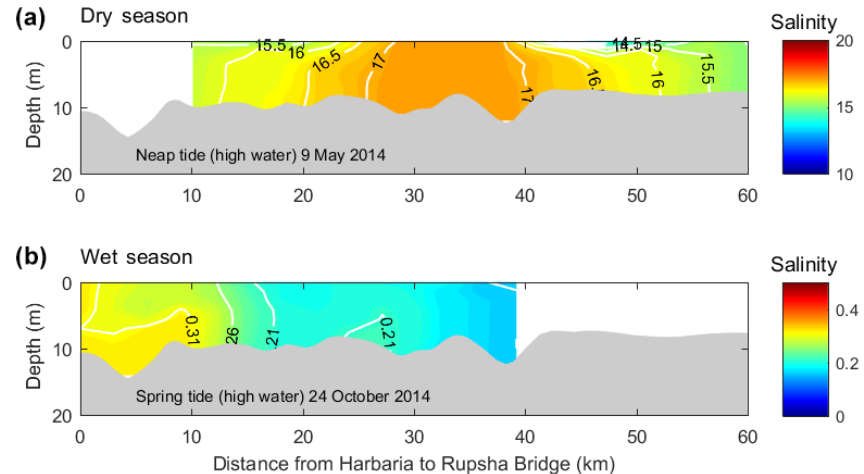
Figure 3. (a) Vertical salinity sections obtained along the main axis of the Pasur River estuary during the dry season. A salt plug developed near Chalna, 34km upstream of Harbaria. (b) Vertical salinity sections obtained along the main axis of the Pasur River estuary during the wet season. The salt plug disappeared and a typical estuarine system developed.